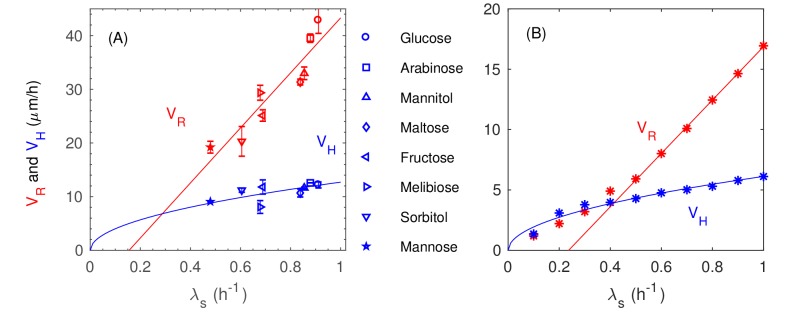
Experimental measurement on VR and VH with various batch culture growth rates.Data are fitted with the stright line VR=51.27λS−7.96 and the squre root curve VH=12.7λS for the redial and vertical speeds of expansion VR and VH respectively. (B) Simulation results on VR and VH with various batch culture growth rates and with a variable diviting length ldiv. data are fitted for λS≥0.5h−1 using the straight line VR=22.1λS−5.24 the squre-root curve VH=6.12λS, respectively.